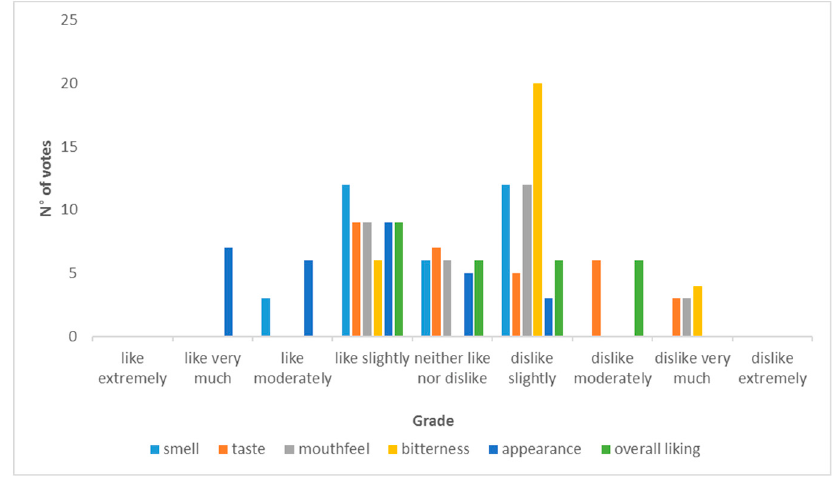
Figure 13. Hedonic nine-point scale grading for beer 4 (25% lactose and 75% coffee).